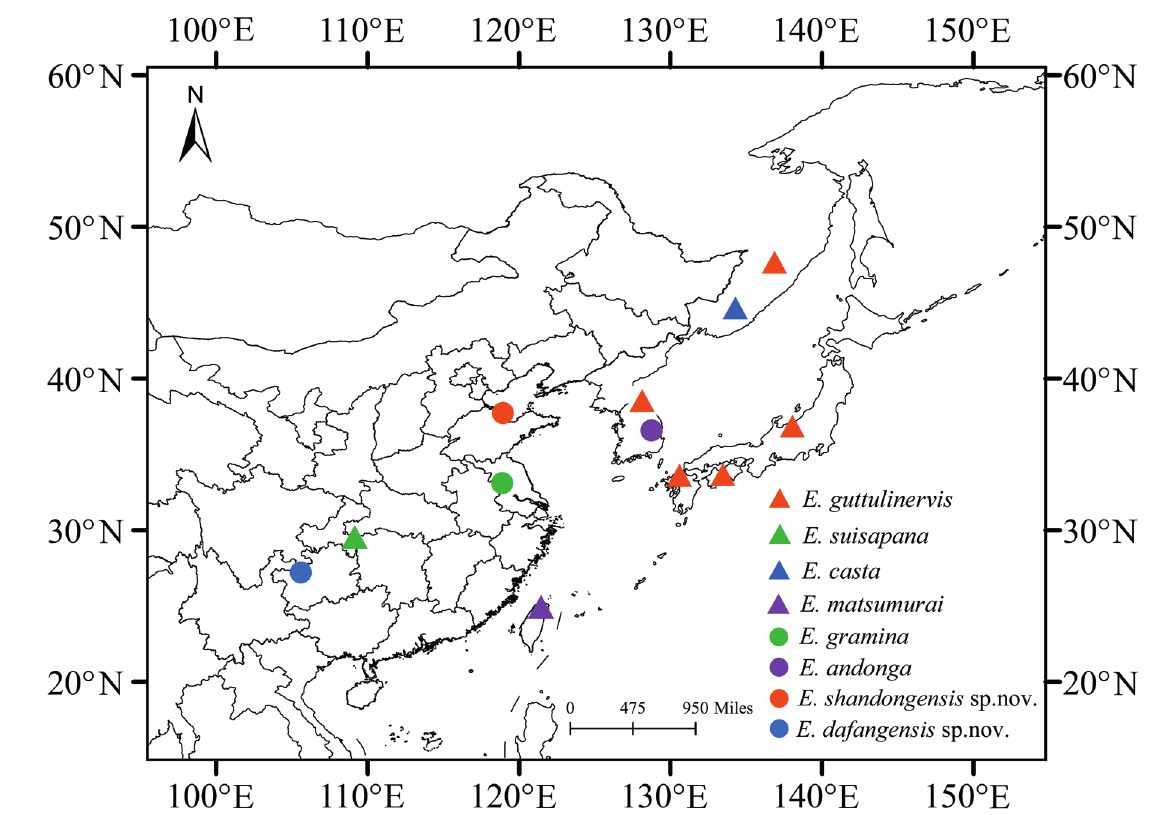
Fig 21. Geographic distribution of species of Eponisiella Emeljanov,